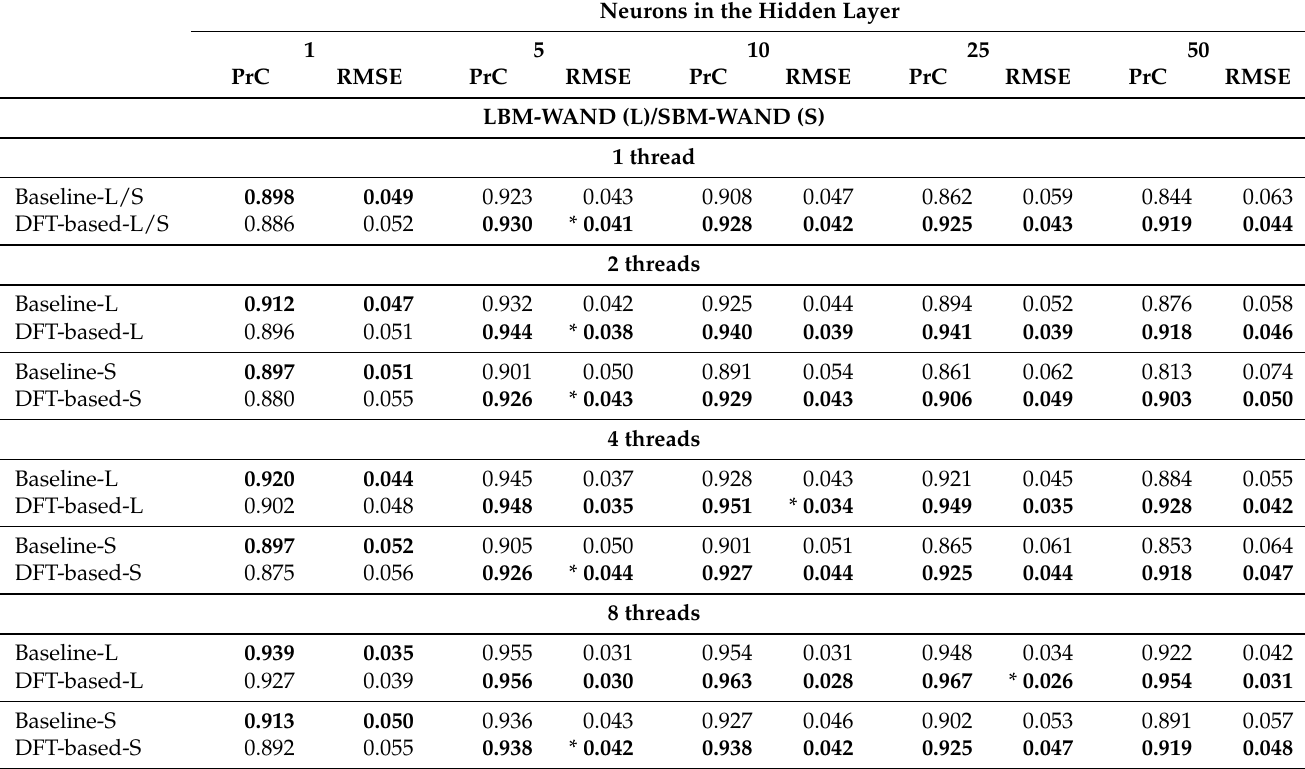
Table 8. Prediction ability of the baseline and proposed algorithms for query running time prediction under two multi- threaded query processing strategies for different number of threads. For each case the best value for Pearson Correlation (PrC) and error RMSE are indicated in boldface type. The smallest RMSE values are indicated with *. The correlation and error values are obtained by comparing against the actual implementation of each multi-threaded query processing strategy: